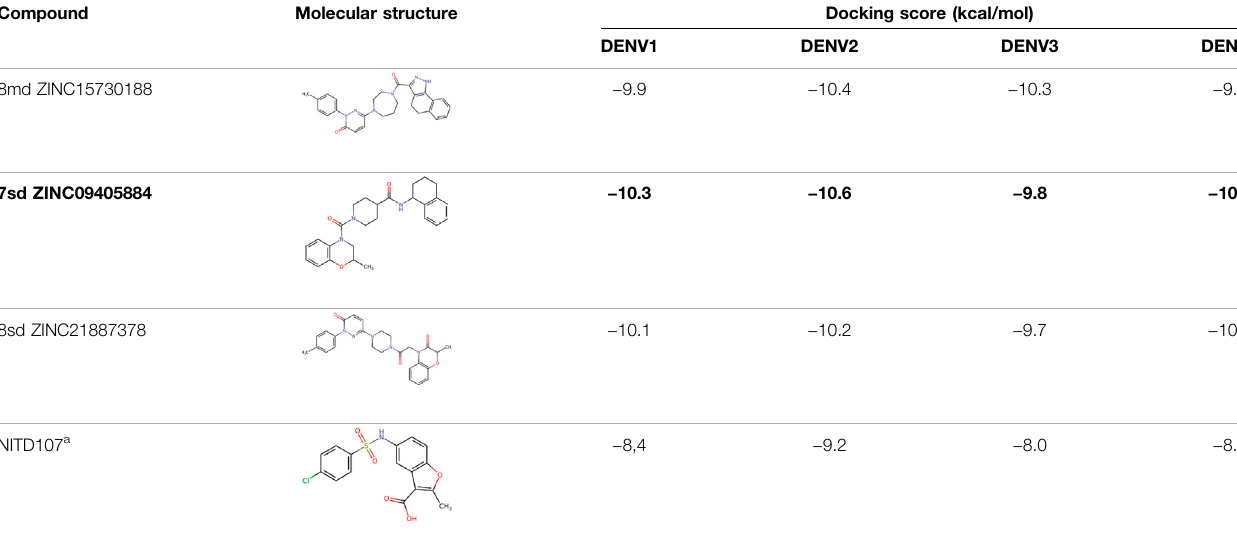
TABLE 6 | Best compounds obtained for the GDD motif of the four dengue serotypes. The best compound is highlighted in bold. Compound Molecular structure